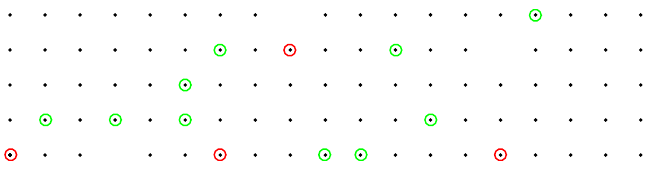
Figure 5. Euratech topology and ProxySelection+